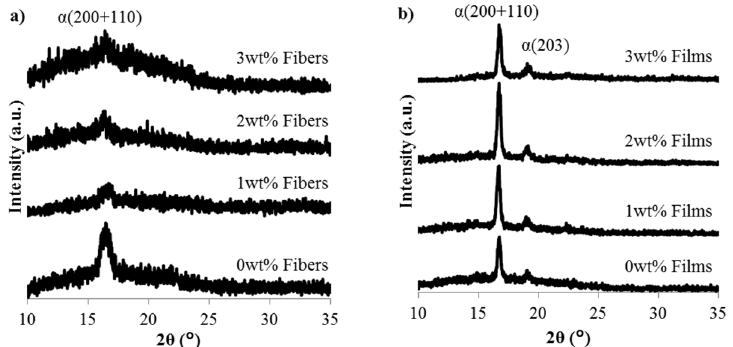
Figure 3. Diffraction patterns obtained for the CNC/PLA ( a ) fibers and ( b ) films as a function of CNC content.